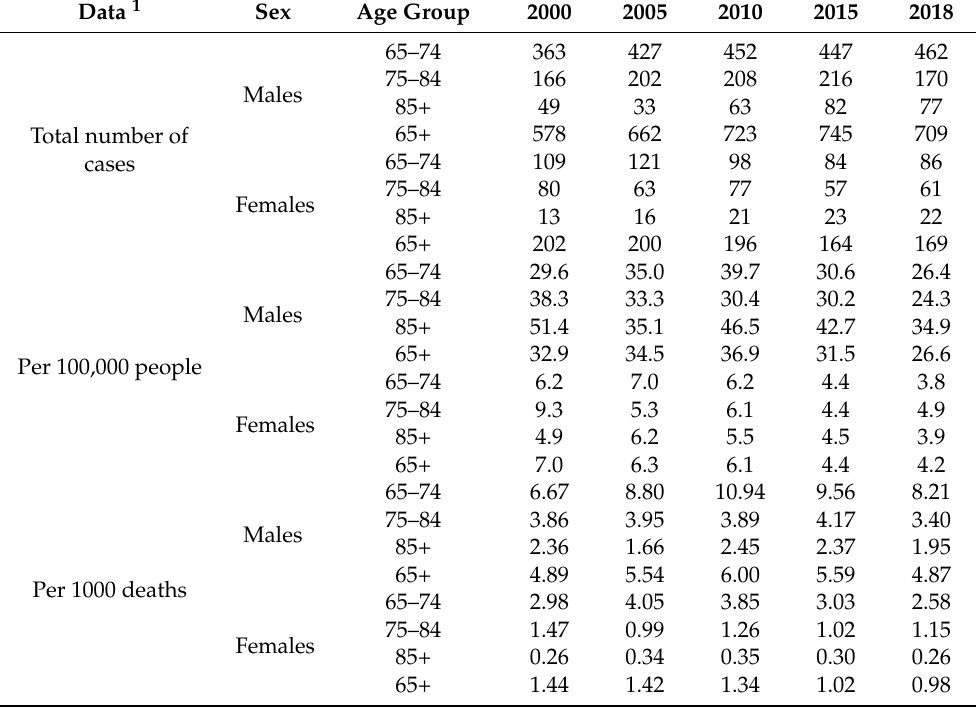
Table 1. Suicide rates among adults aged 65 or older in Poland from 2000 to